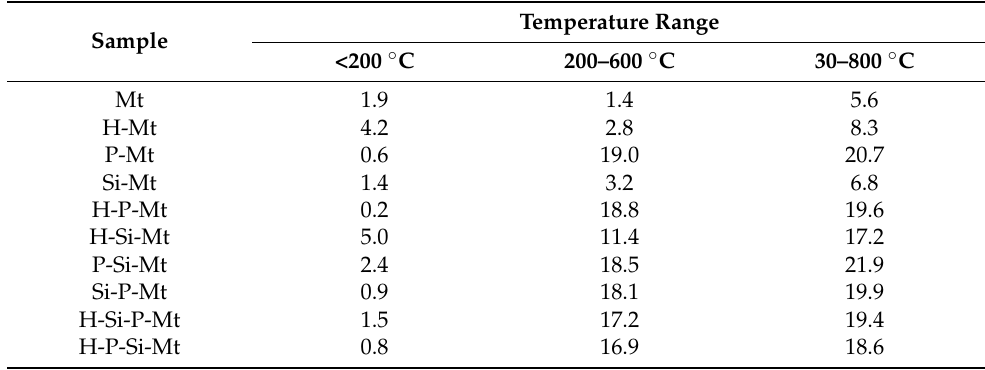
Table 3. Relative mass loss during decomposition of Mt and modified Mt samples